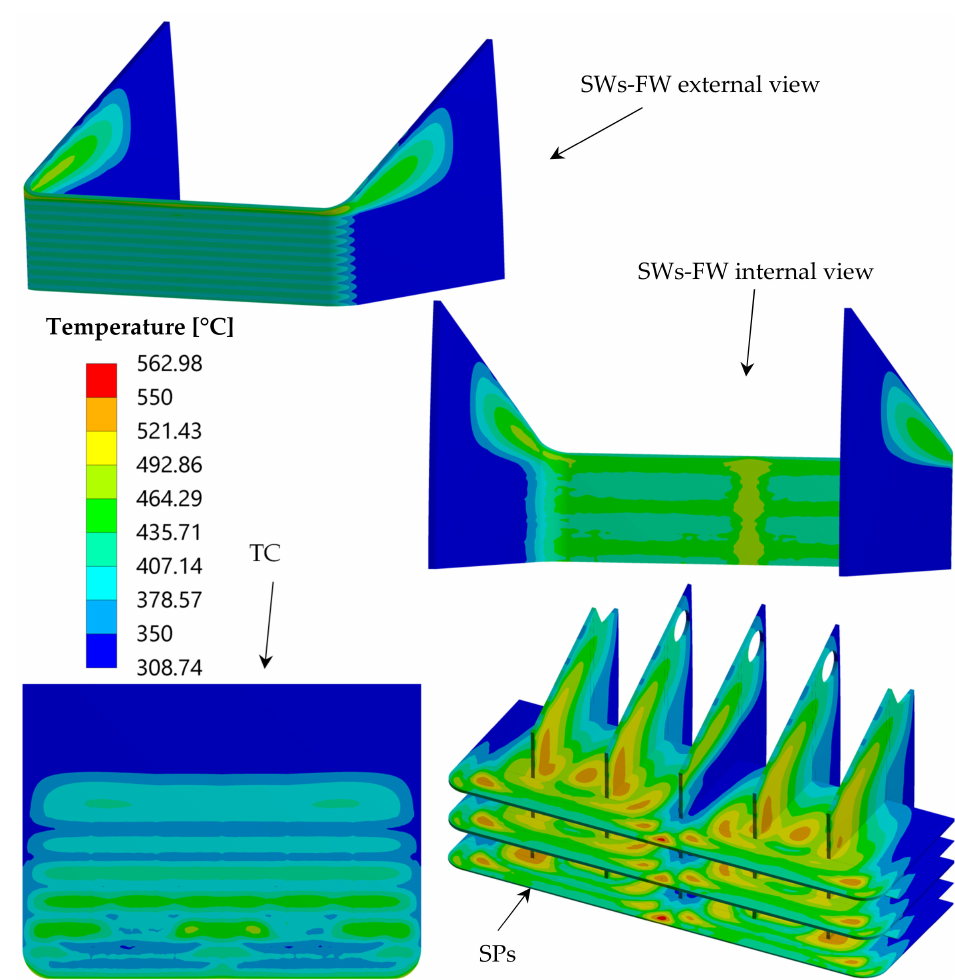
Figure 5. TC region-mod configuration—temperature spatial distribution within Eurofer.